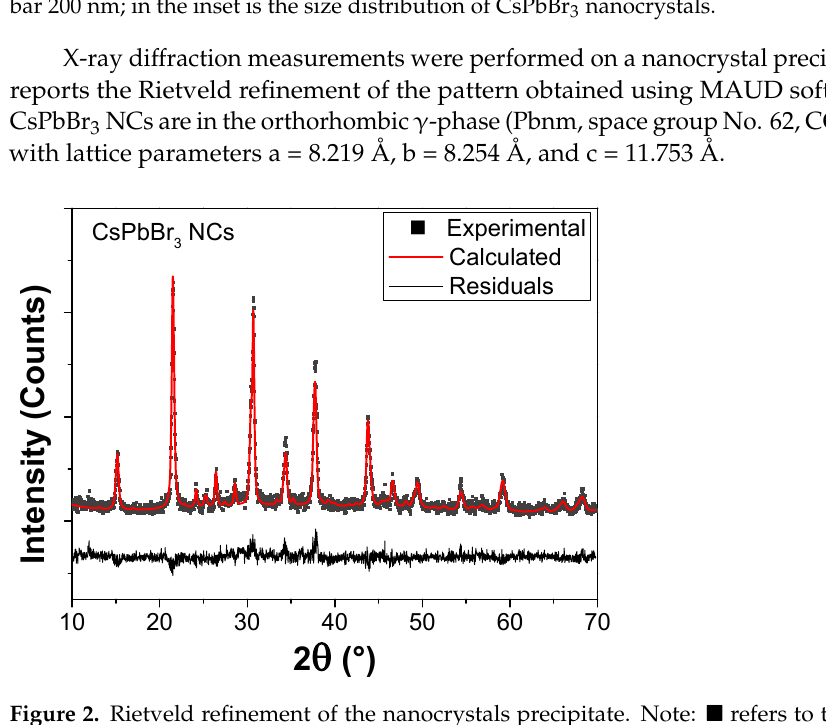
Figure 2. Rietveld refinement of the nanocrystals precipitate. Note: (cid:4) refers to the experimental pattern, the red line is the pattern calculated via Rietveld refinement, while the black line shows the residuals between the experimental and calculated